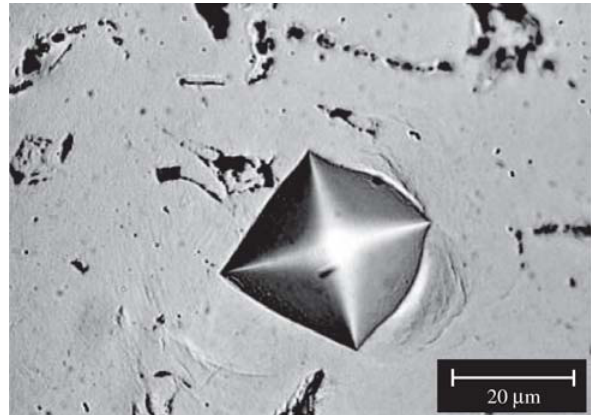
Figure 9. Vickers impression on top of aluminum. Load = 255 mN.